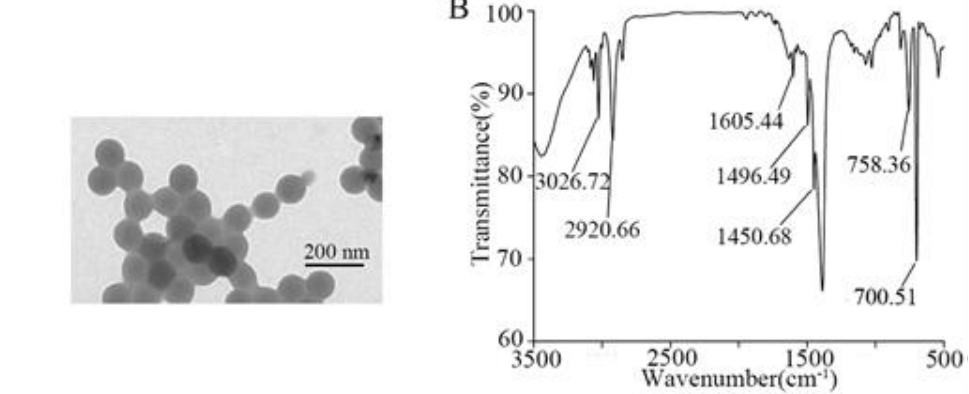
Figure 1. Nanopolystyrene particles (NPs) properties. ( A ) Transmission electron microscopy (TEM) image of NP suspension before the sonication. ( B ) FTIR spectrum of NPs.